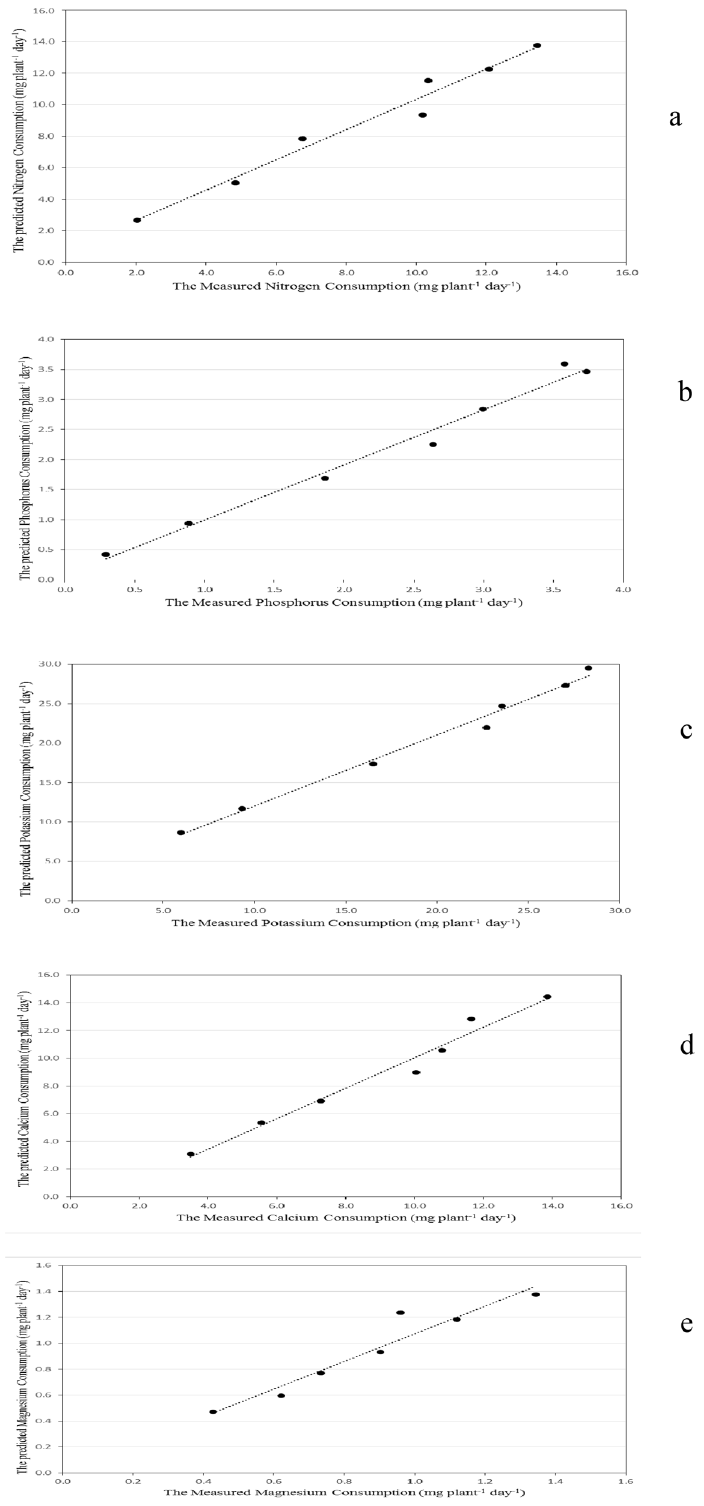
Figure 9. The comparison between the predicted and the measured nutrients consumption by basil plants during the whole growth period. ( a ) N, ( b ) P, ( c ) K, ( d ) Ca, ( e )